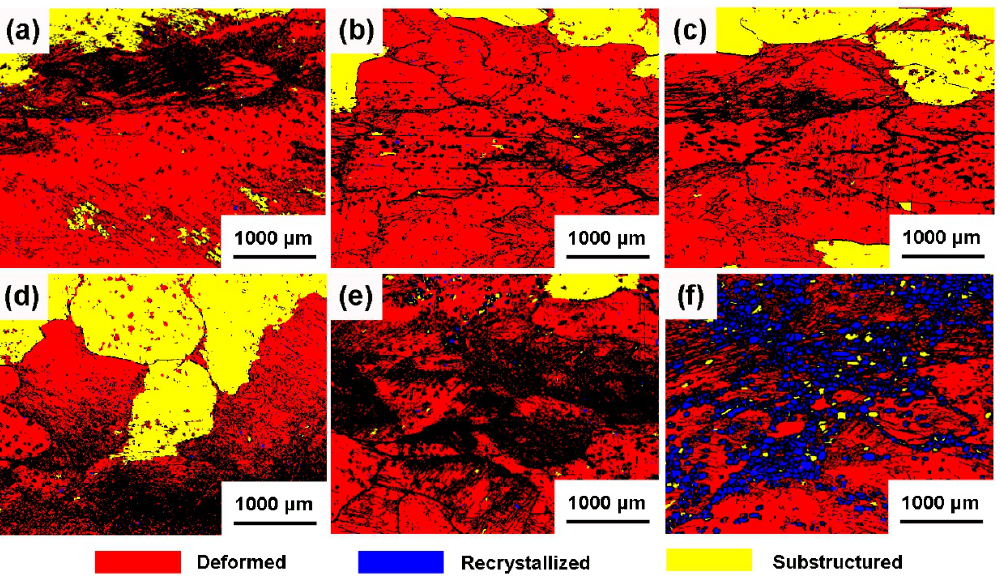
Figure 7. The EBSD recrystallization maps (BC + DefRex + GB) of specimens compressed at 0.1 s −1 with different temperatures of 950 °C ( a ), 1050 °C ( b ), 1150 °C ( c ), and compressed at 1 s −1 with different temperatures of 1050 °C ( d ), 1150 °C ( e ), 1250 °C ( f ). The red area in the figure represents deformed grain, the yellow area represents substructure, the blue area represents recrystallized grain, and the black area represents grain boundary or band-like structure where the stress is concentrated.